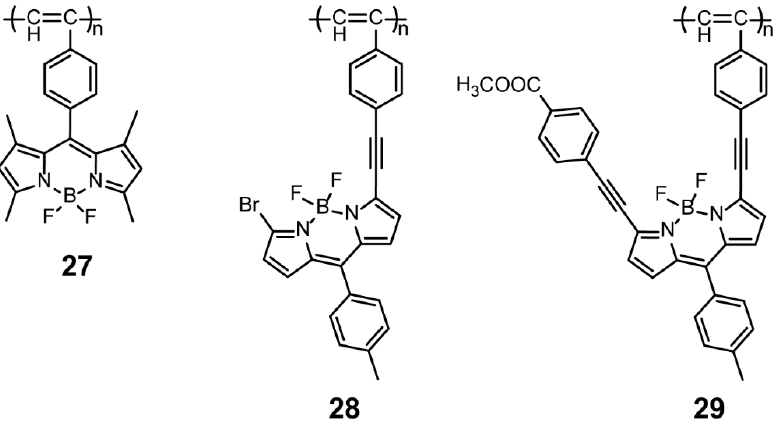
Figure 9. Chemical structures of polymers 27 – 29 ( Reproduced with permission from Reference [55]. Copyright @ 2014, Royal Society of Chemistry).